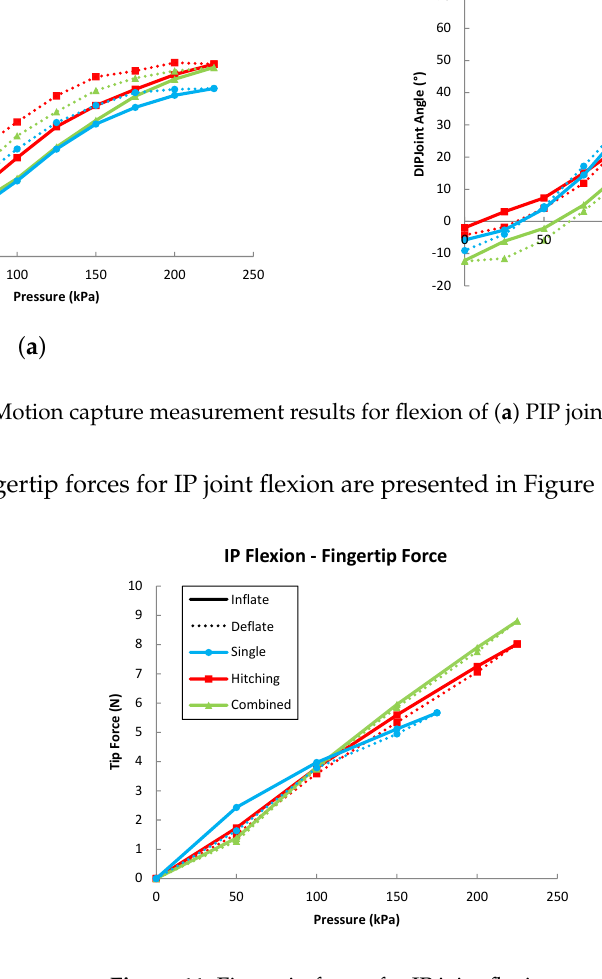
Figure 11. Fingertip forces for IP joint